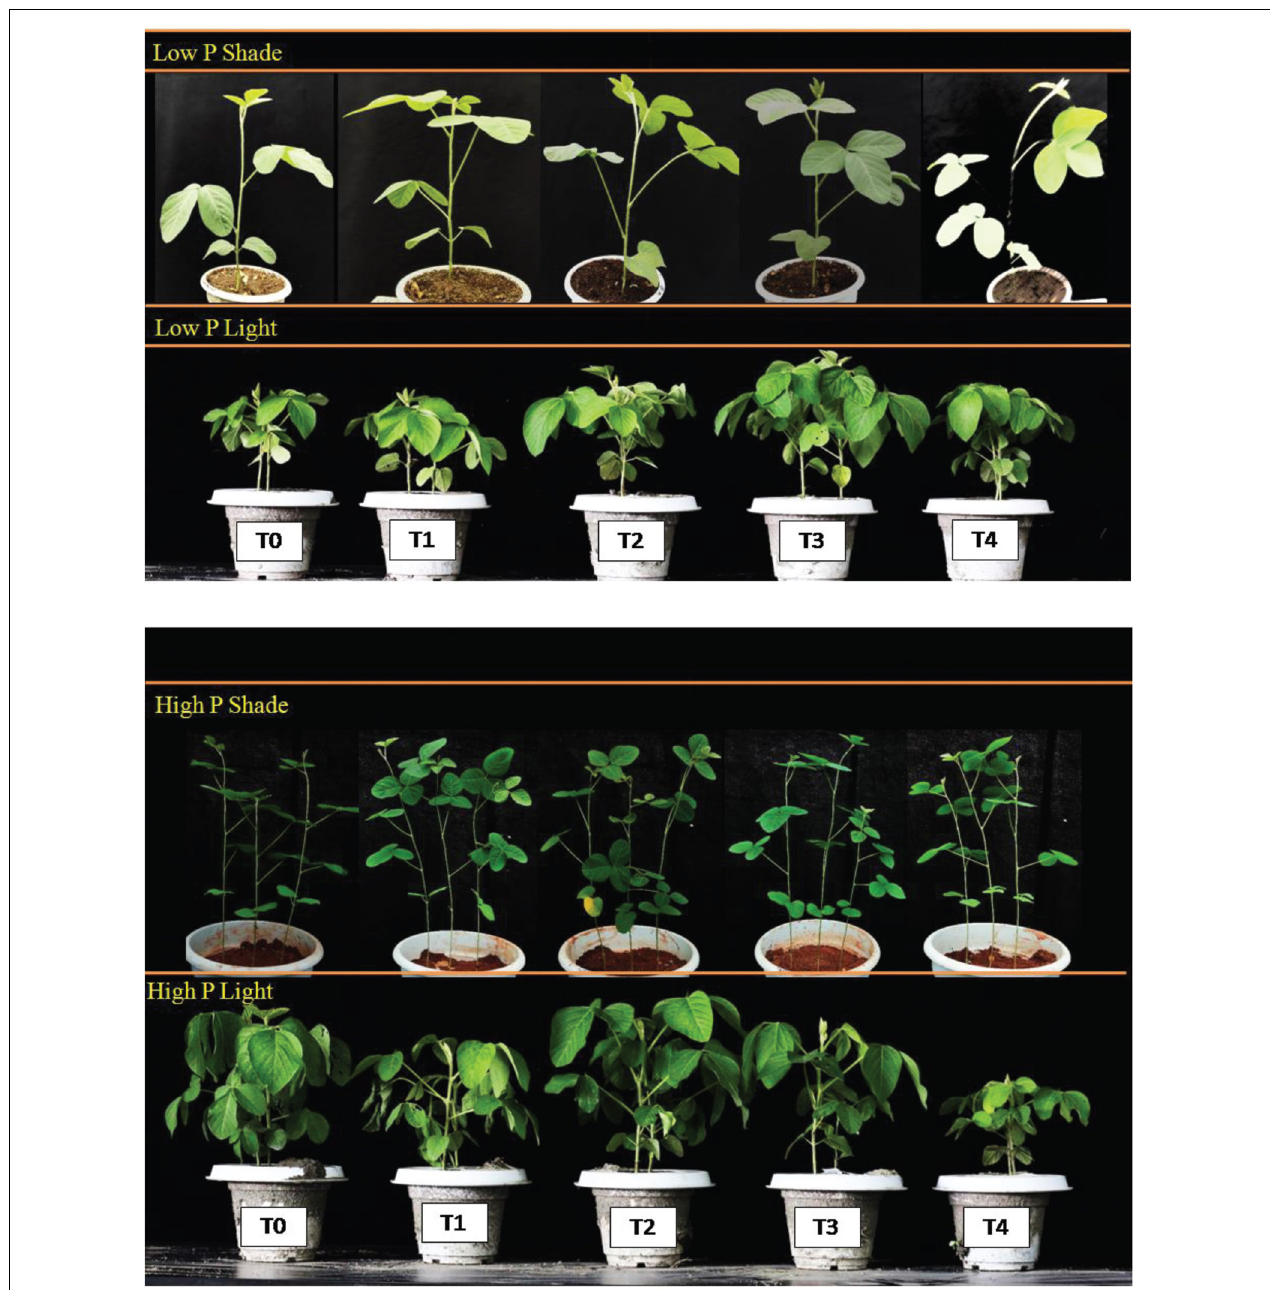
FIGURE 2 | Phenotypic demonstration of soybean plants under variable phosphorus (HP, LP) and light environment (NL,